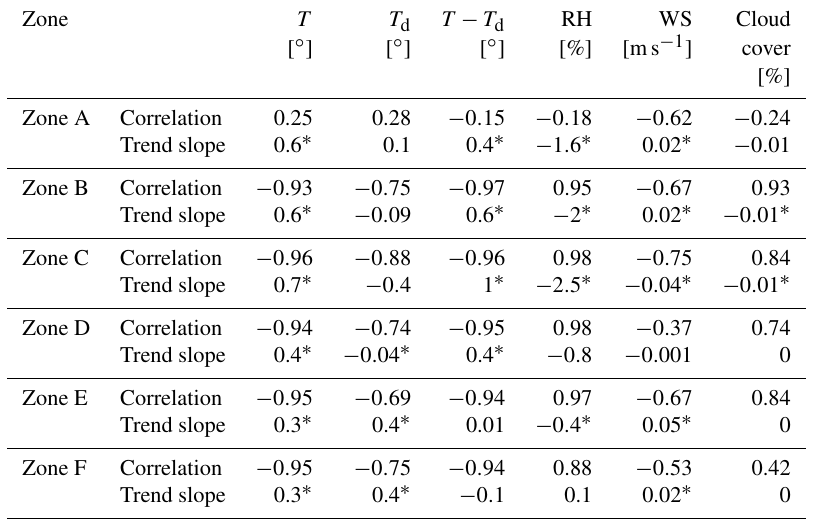
Table 5. Correlation between long-term mean daily dew yield and meteorological parameters obtained from ERA-Interim for the time period 1979–2018 and Sen’s trend slope in the meteorological variables per decade (i.e., 10 years). Zone T T d T − T d RH WS